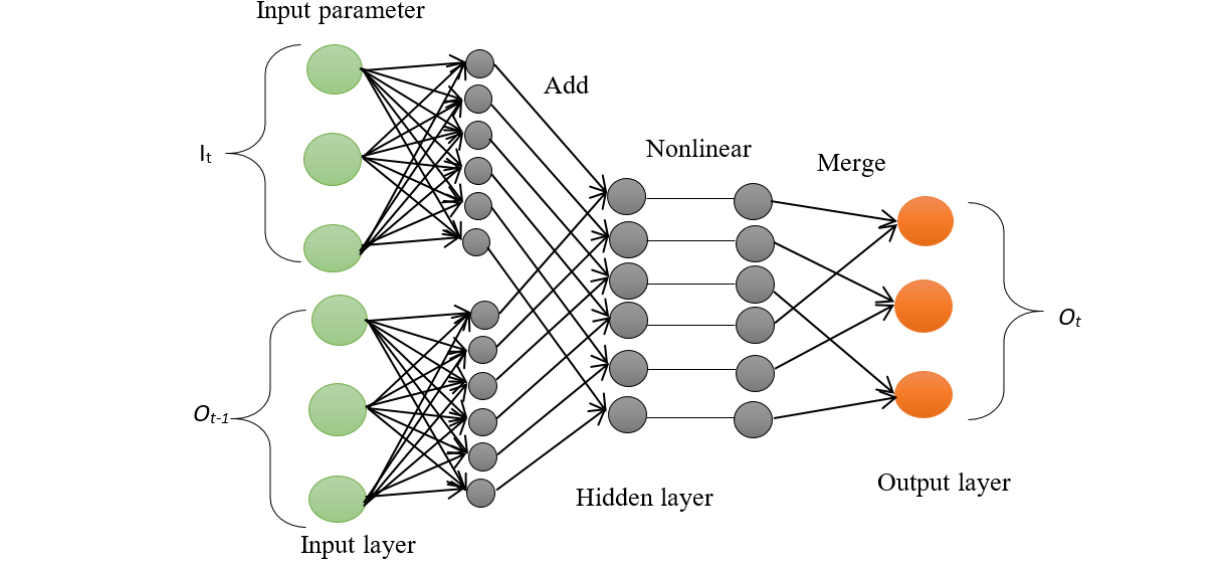
Figure 6. Feedforward recurrent neural network implementation. The final output from the output layer is fed back as part the input in the input layer. Where It and Ot are the input and output at time t and Ot-1 is the output for the previous input at time t-1.